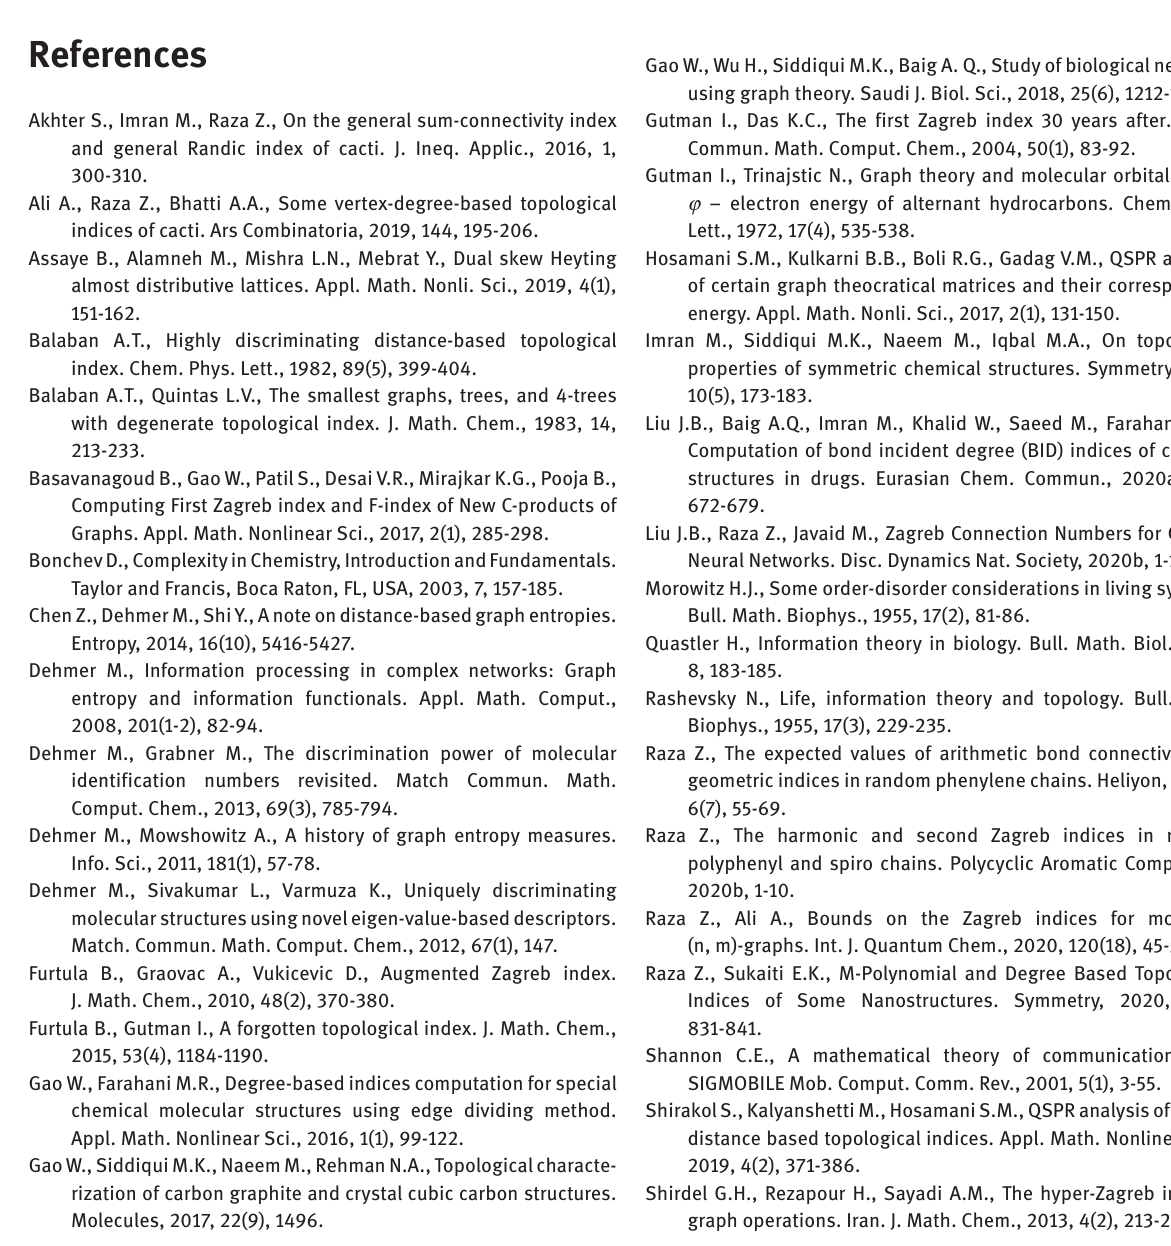
Figure 10: (a) The augmented Zagreb entropy, (b) the Balaban